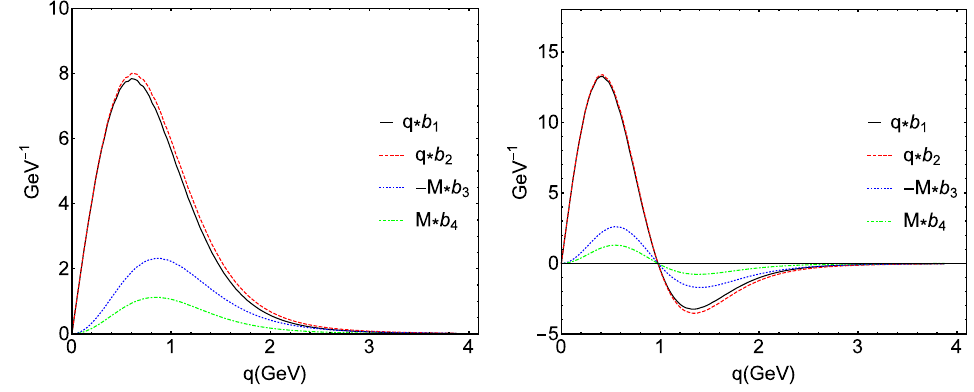
Figure 2 . The 0 + wave functions of the state B ∗ (right). b 1 and b 2 terms are P waves; b 3 and b 4 terms are S